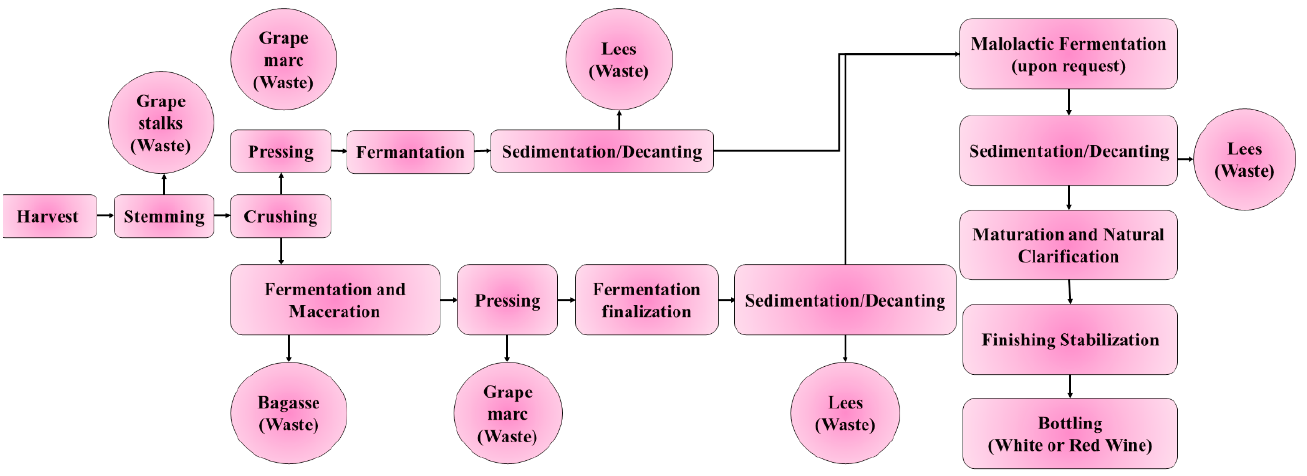
Figure 1. Vini fi cation process diagram. Figure 1. Vinification process